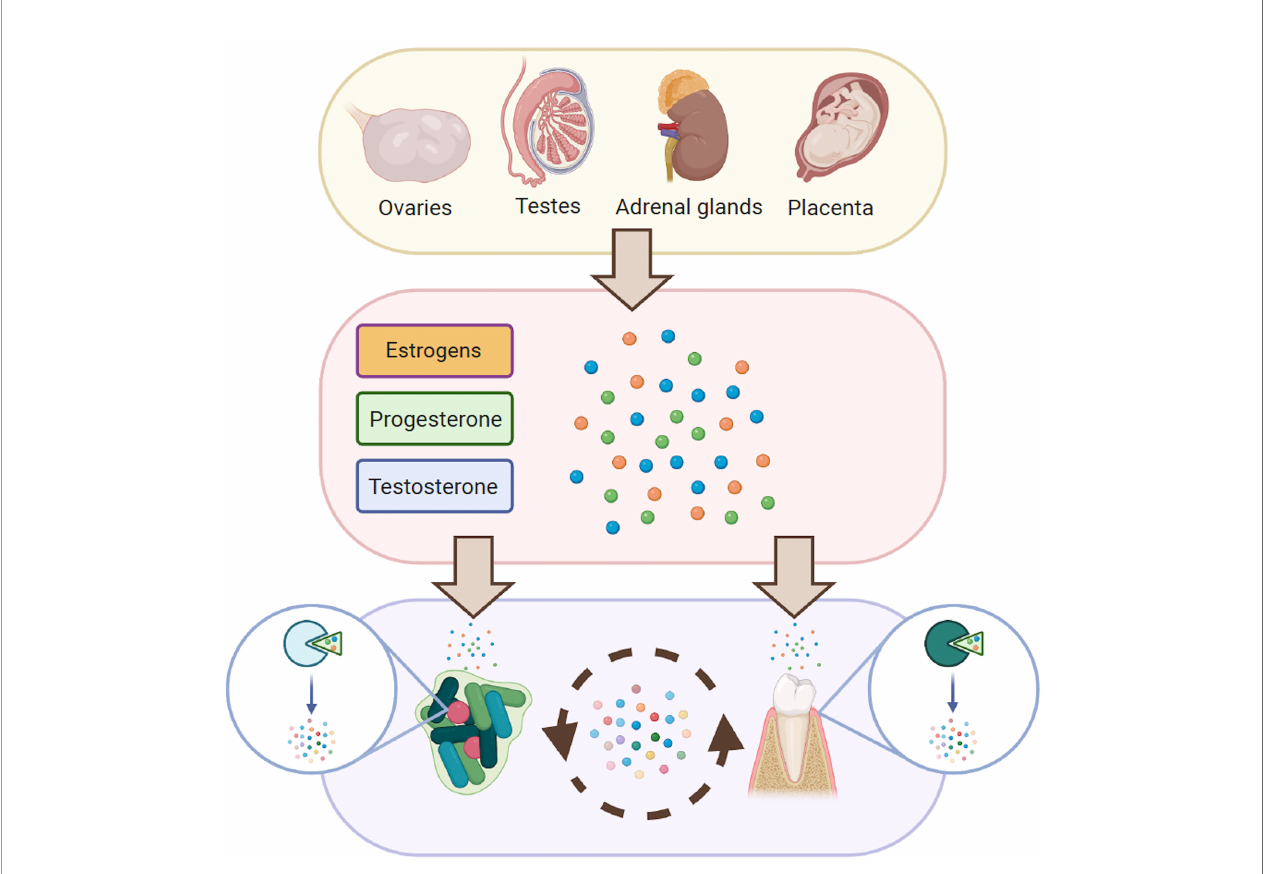
FIGURE 2 | Proposed interaction between SSH, the host and its microbiome. Solid arrows represent known interactions between SSH, oral microorganisms and oral tissues. Dashed arrows represent hypothesized